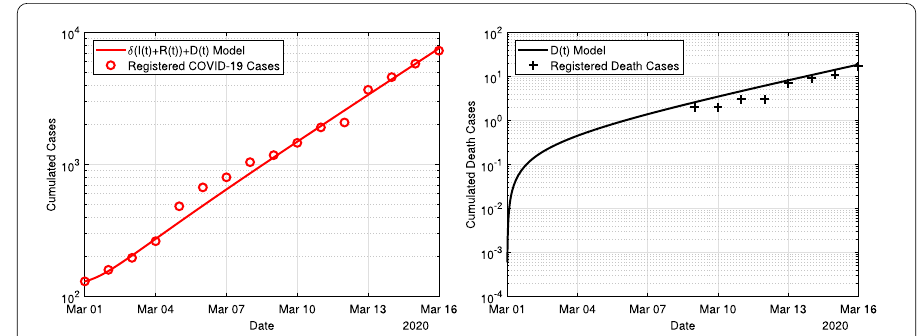
Figure 5 Fit of the basic model (1a)–(1e) to the data for the period 1 March to 16 March, i.e. before the onset of containment measures